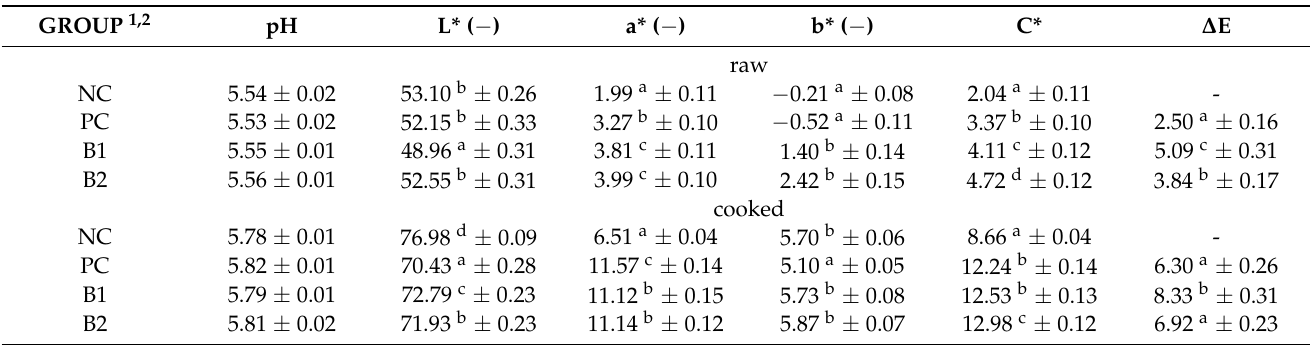
Table 1. The effect of alternative nitrite sources on pH and color parameters (mean ± SE) of cured pork loin (n = 9).